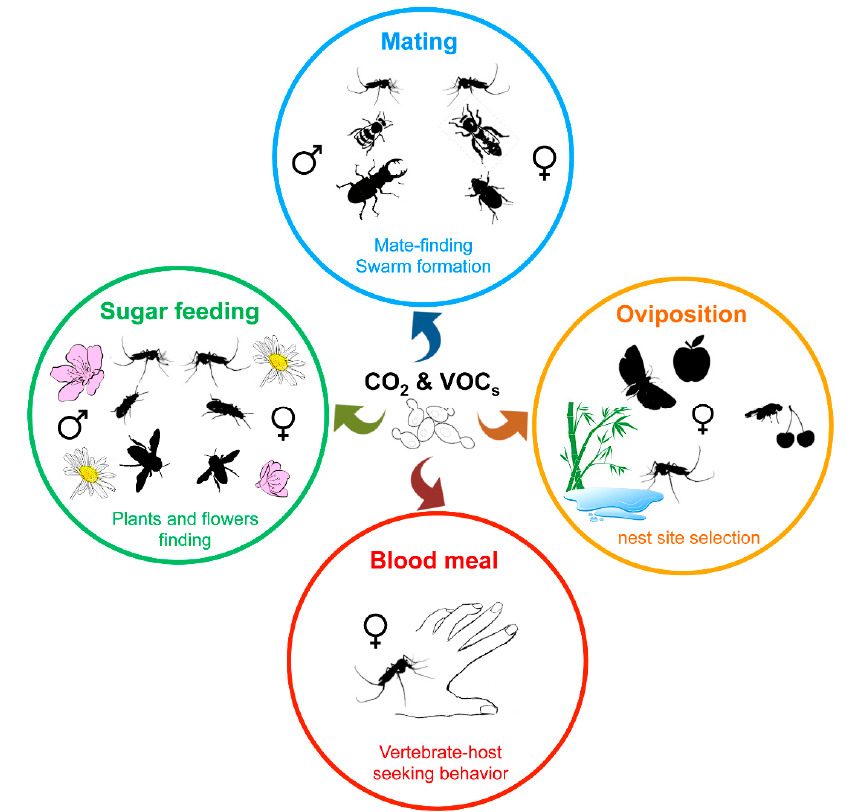
Figure 3. Influence of yeast volatile compounds on blood-sucking and phytophagous insect behavior. Insects use olfactory perception of chemical cues, such as CO 2 or volatile organic compounds (VOCs), to find favorable nest sites for larval development, vertebrate hosts, flowering plants, or mating partners.